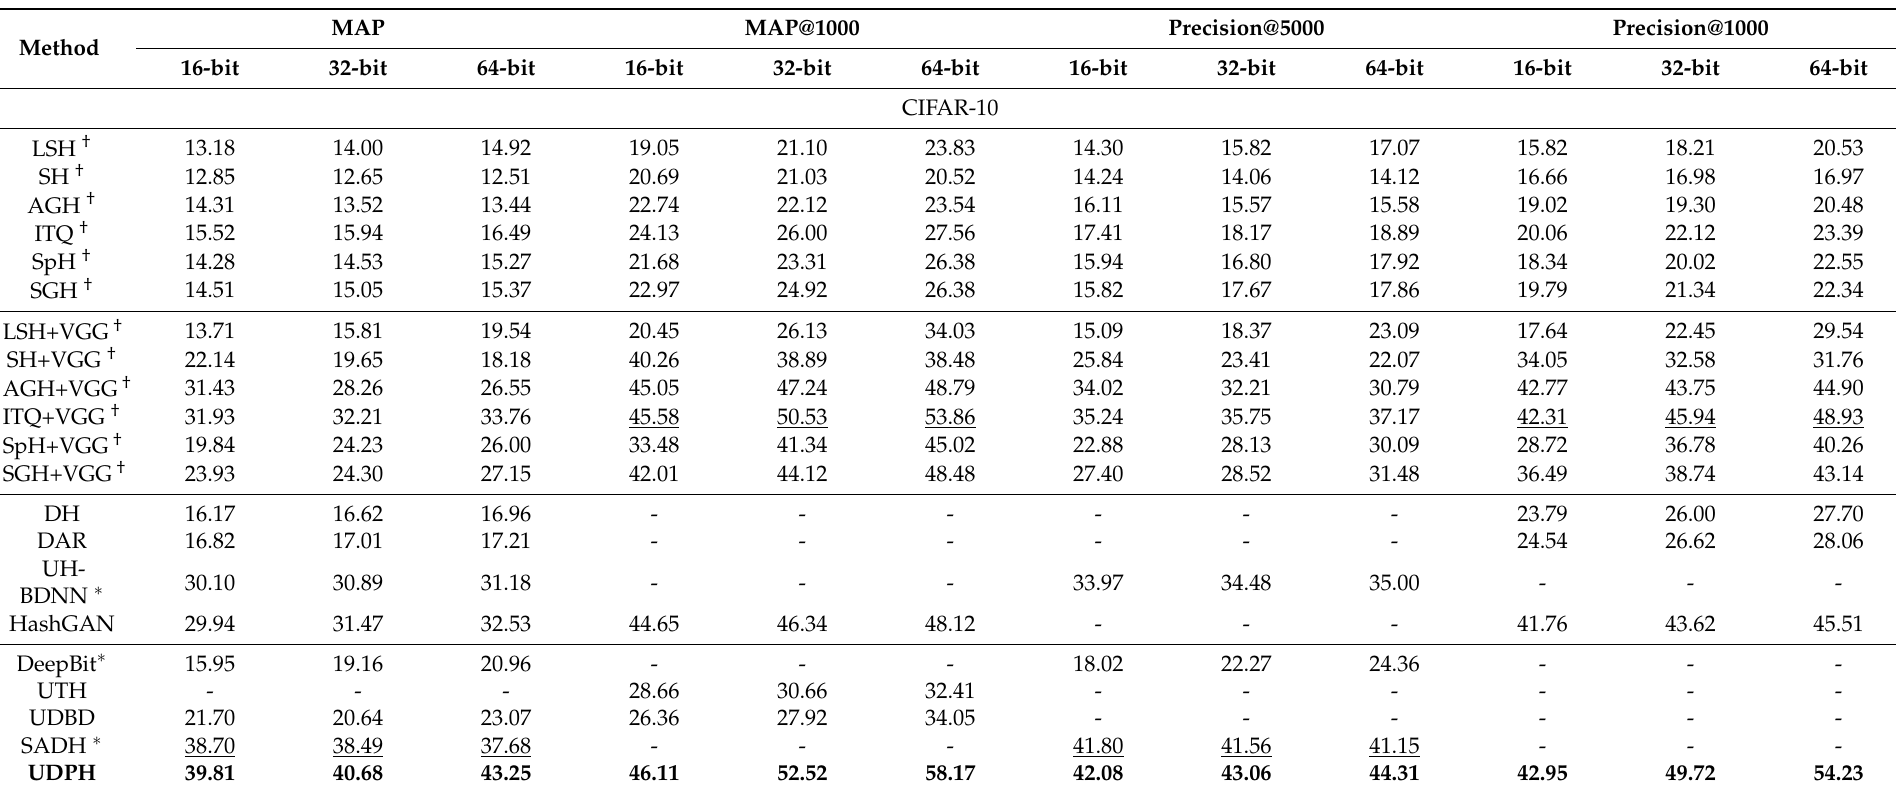
Table 1. Retrieval results (%) in terms of MAP, MAP@1000, Precision@5000, and Precision@1000 on CIFAR-10 and NUS-WIDE. † denotes the implemented results based on the provided codes, ∗ means the results copied from Shen et al., 2018 [15], and the other results are directly copied from the corresponding publications. The best accuracy are in bold and the second-best results of each database are